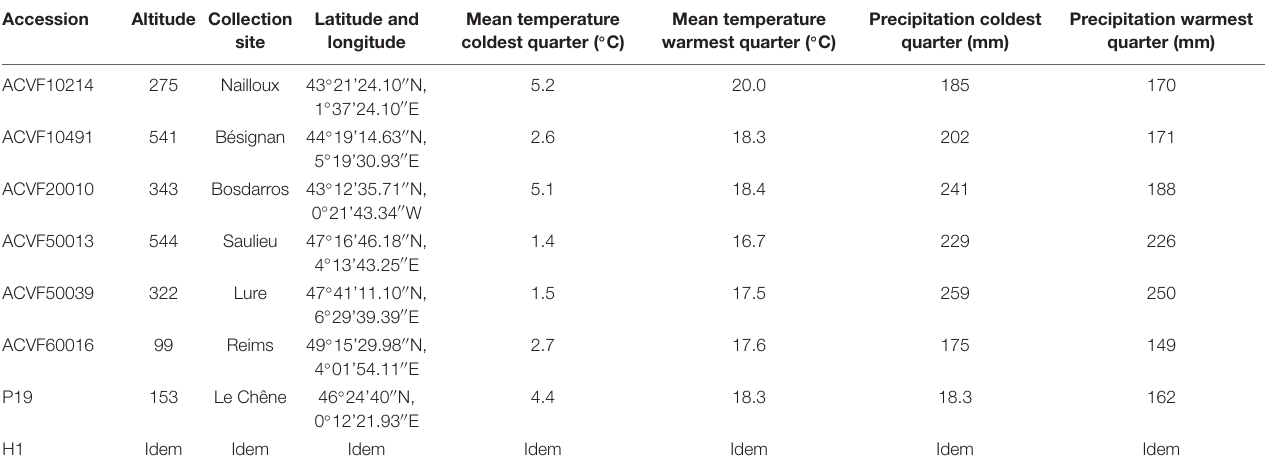
TABLE 1 | List of six wild populations of Lolium perenne L. collected in different sites in France and two populations from a selection program (P19 and H1) obtained by divergent selection at INRAE-URP3F, Lusignan, France. Accession Altitude Collection Latitude and Mean temperature Mean temperature Precipitation coldest Precipitation warmest site longitude coldest quarter ( ◦ C) warmest quarter ( ◦ C) quarter (mm) quarter